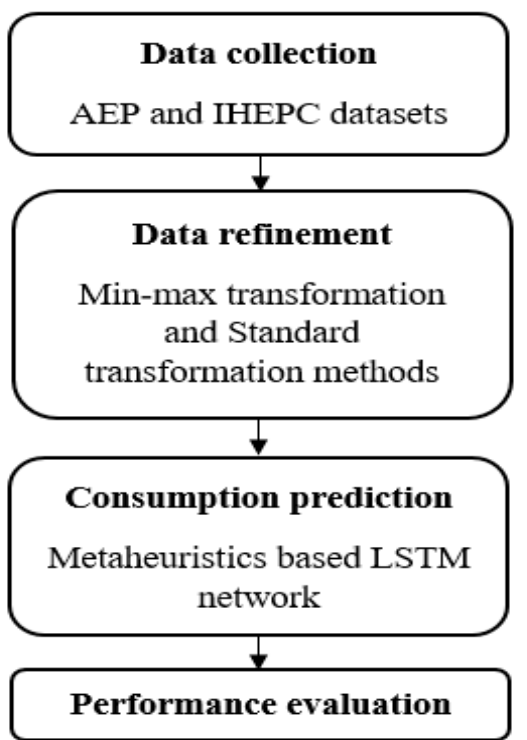
Figure 1. Flow-diagram of the proposed model.